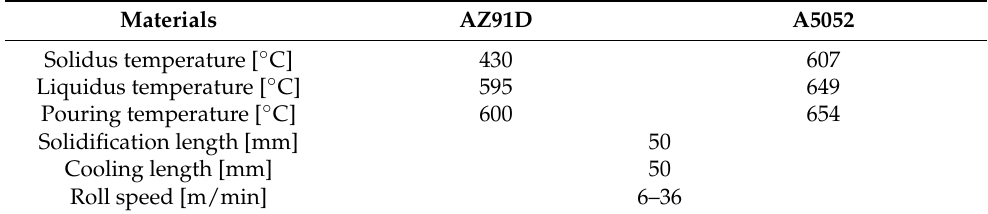
Figure 2. Schematic diagram of single-roll casting. Table 2. Experimental conditions of the single-roll casting experiments for the cast AZ91D and A5052 alloys.